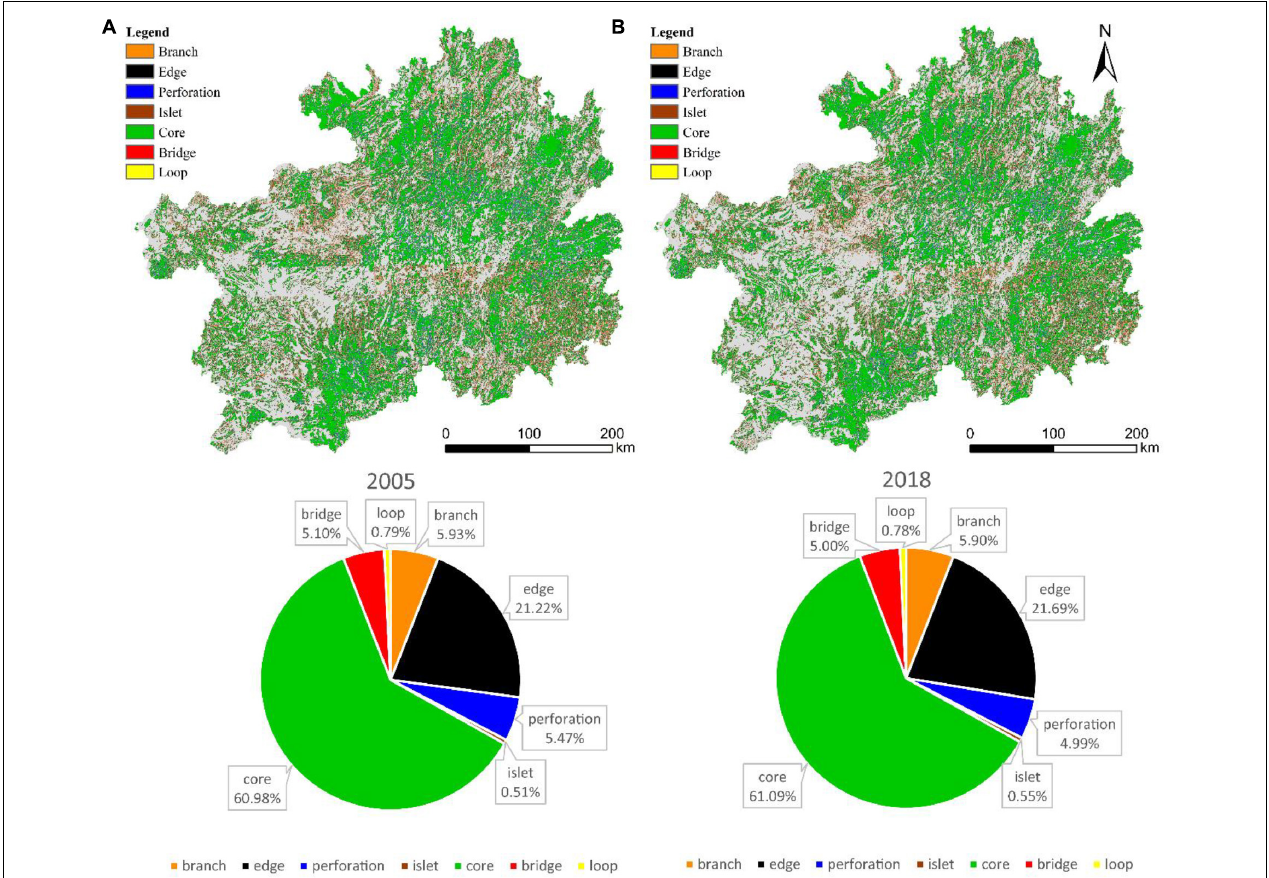
FIGURE 3 | Spatial distributions of morphological spatial pattern analysis (MSPA) in 2005 (A) and 2018 (B) . Percentages of forestland are shown.